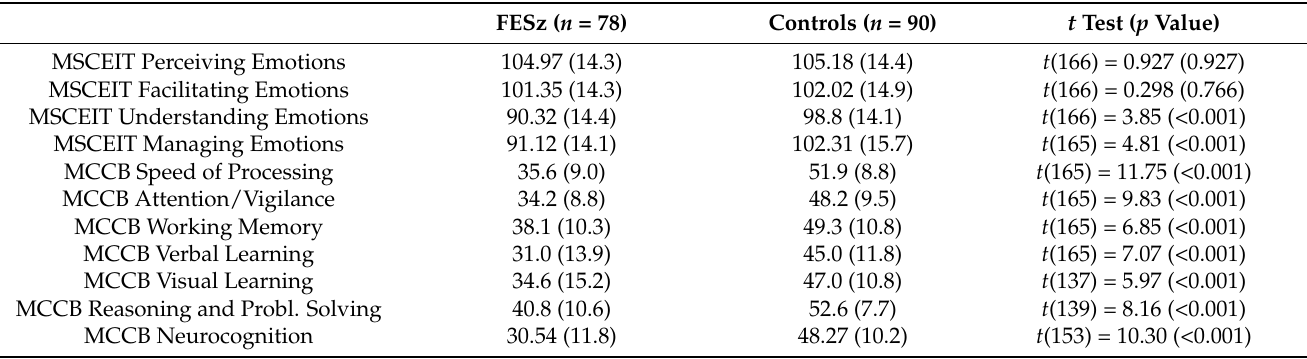
Table 2. Mean (standard deviations) of T-scores of the MSCEIT and MCCB domains (excluding social cognition) and Neurocognition. FESz = first episode of